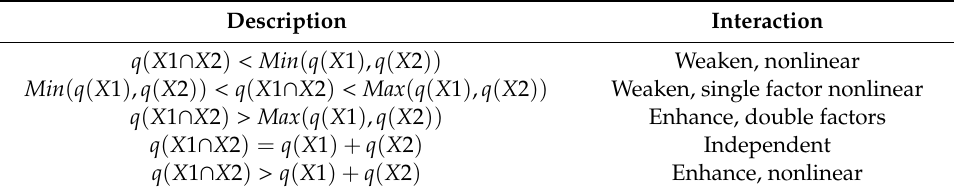
Table 3. Types of interaction between two